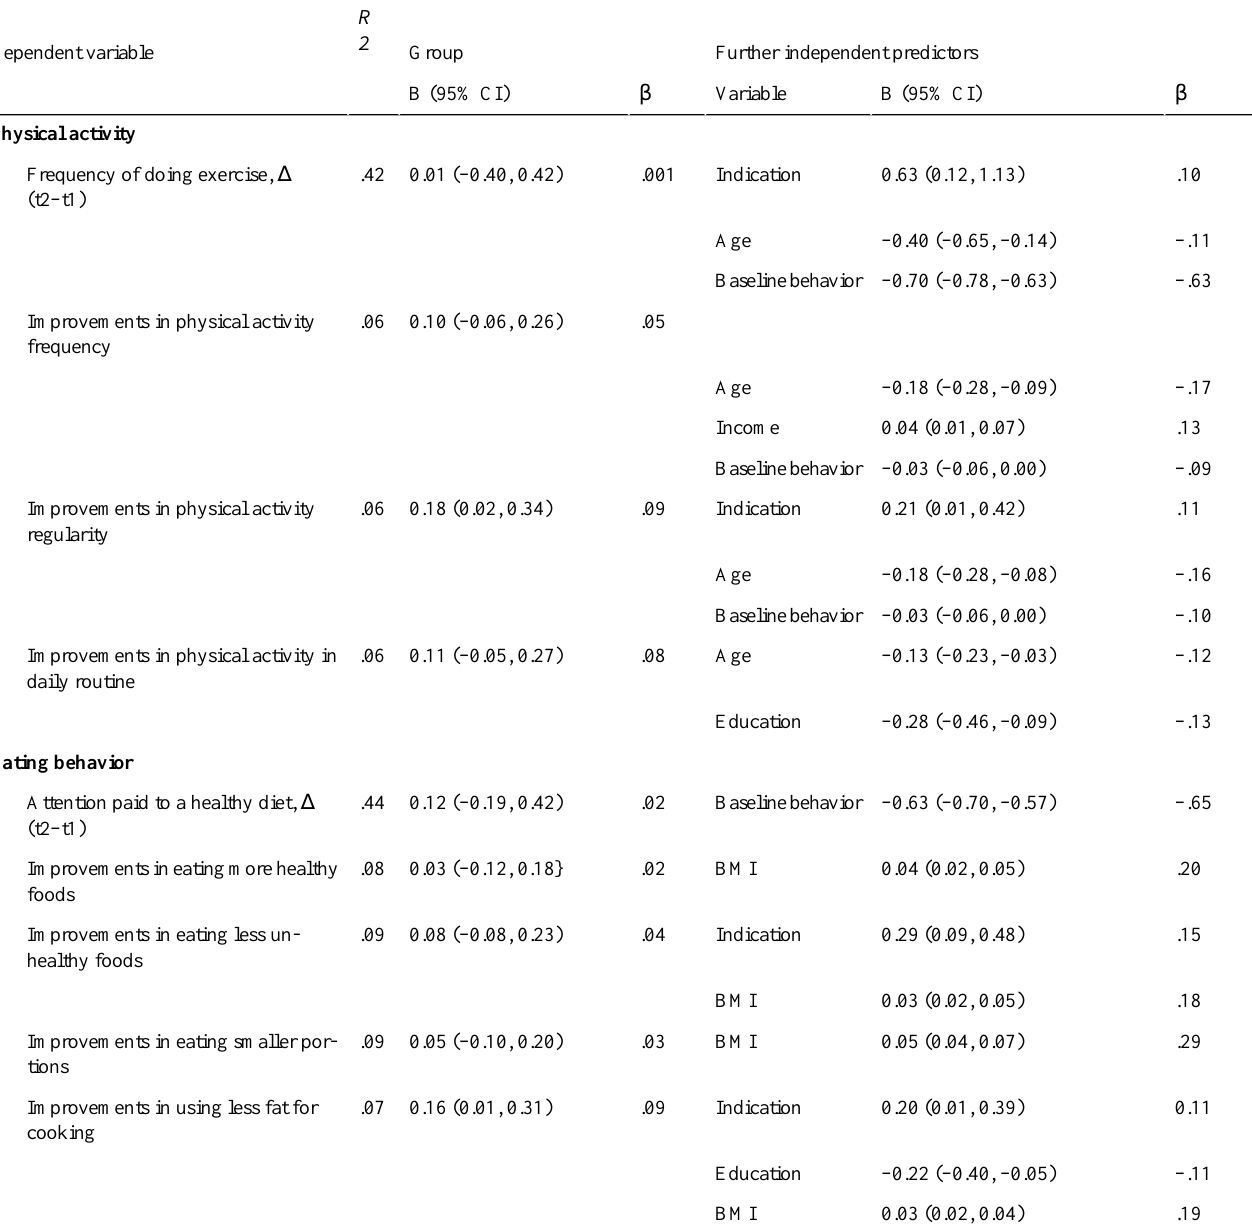
Table 3. Multivariate linear regression—intention-to-treat analysis. Each line starting with a dependent variable contains information from one regression analysis (N=571) and provides model fit ( R 2 ), results for the variable group (regardless of significance), and those variables which were demonstrated to be significant independent predictors in the